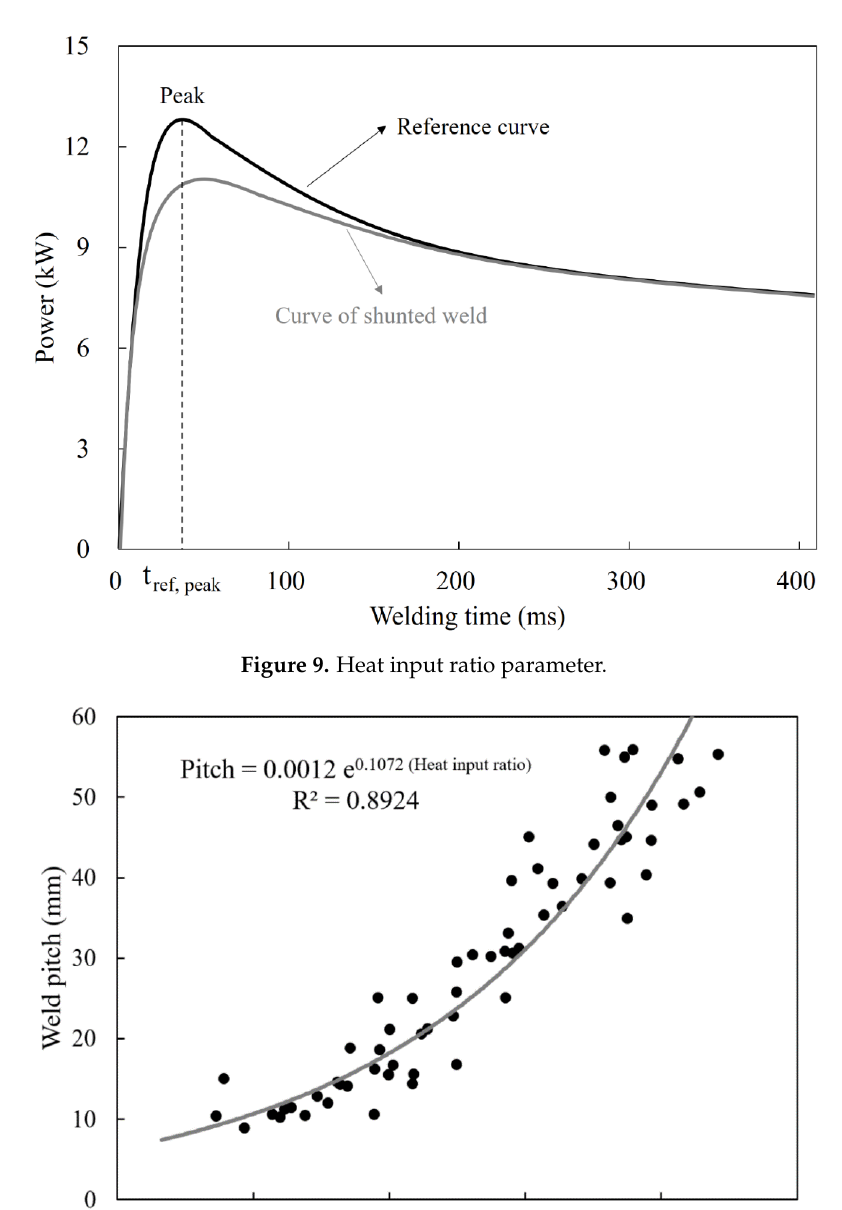
Figure 10. Exponential model used to estimate the weld pitch as a function of the heat input ratio.